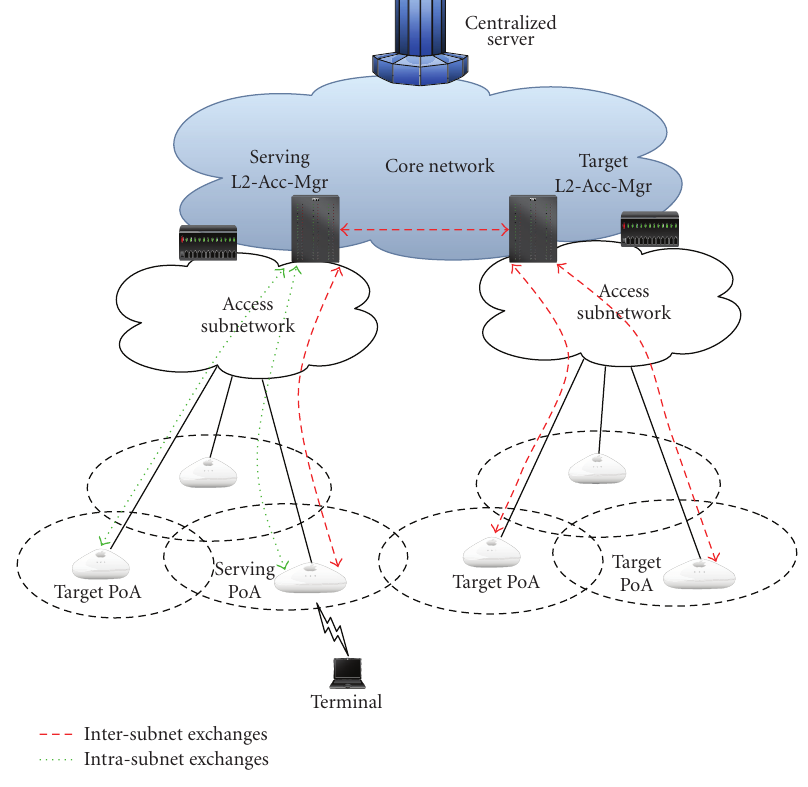
Figure 4: HO management